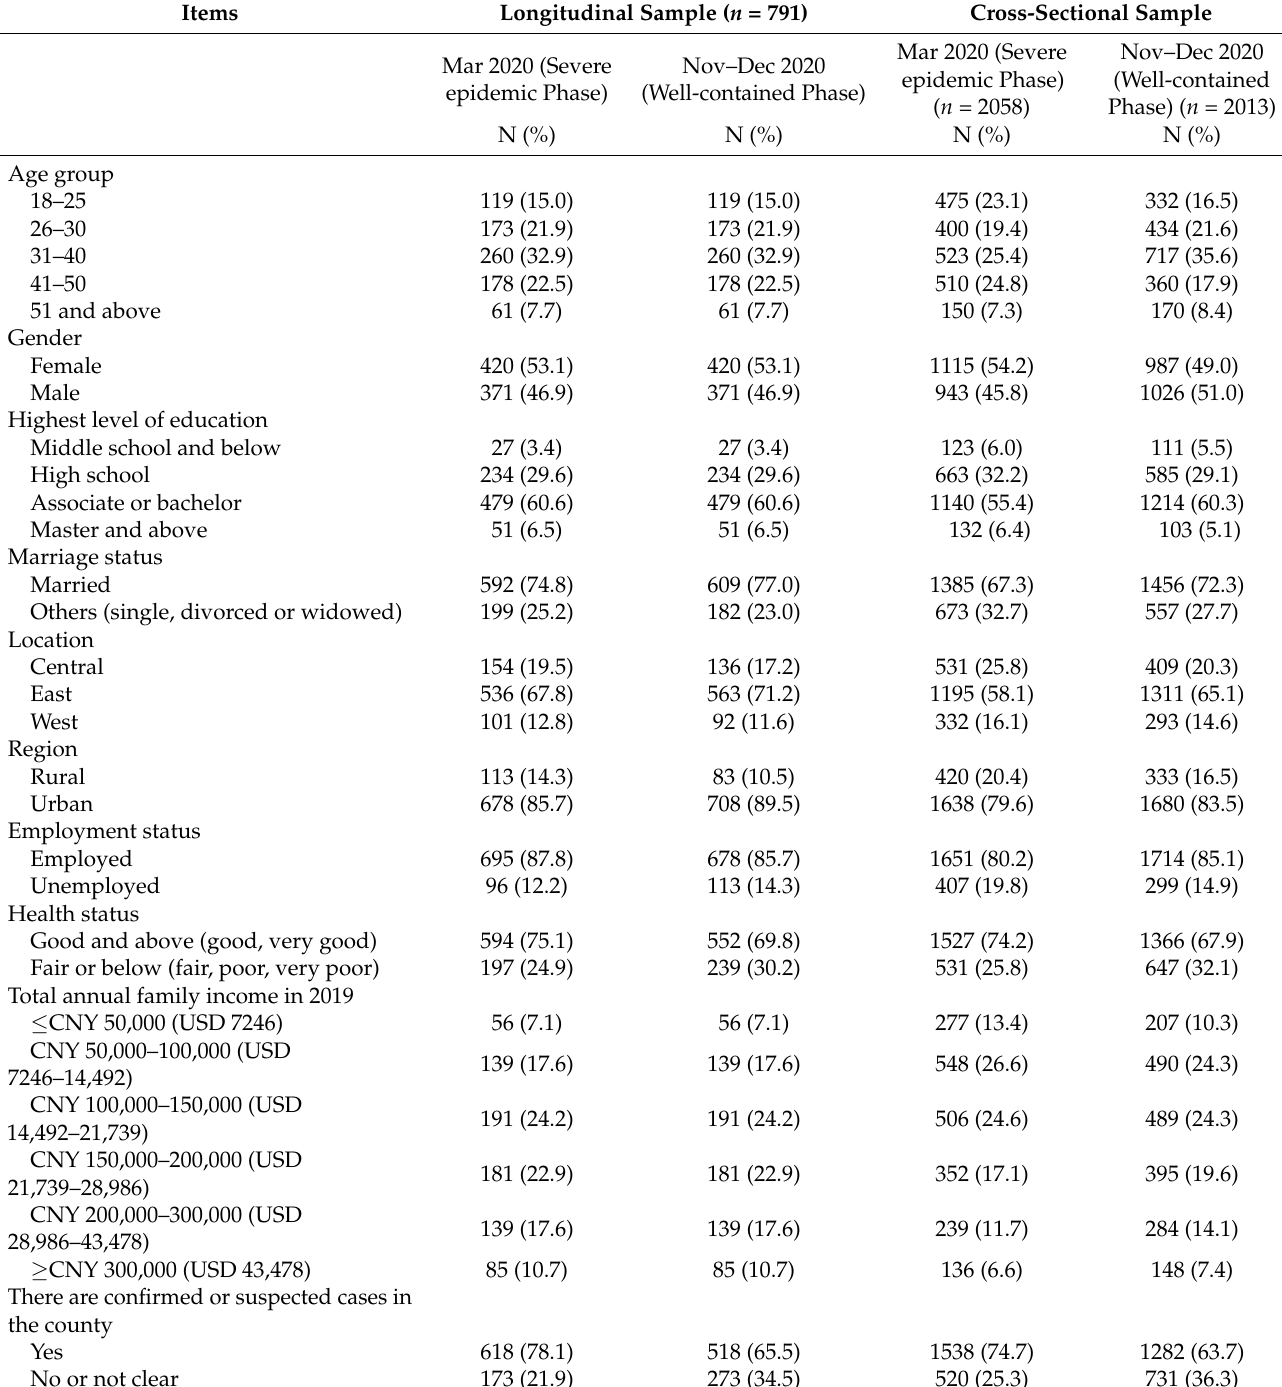
Table A1. Basic characteristics, risk perception, impact of COVID-19, vaccination history, and impact factors among respondents in two consecutive surveys in the severe epidemic phase (Mar 2020) and the well-contained phase (Nov–Dec